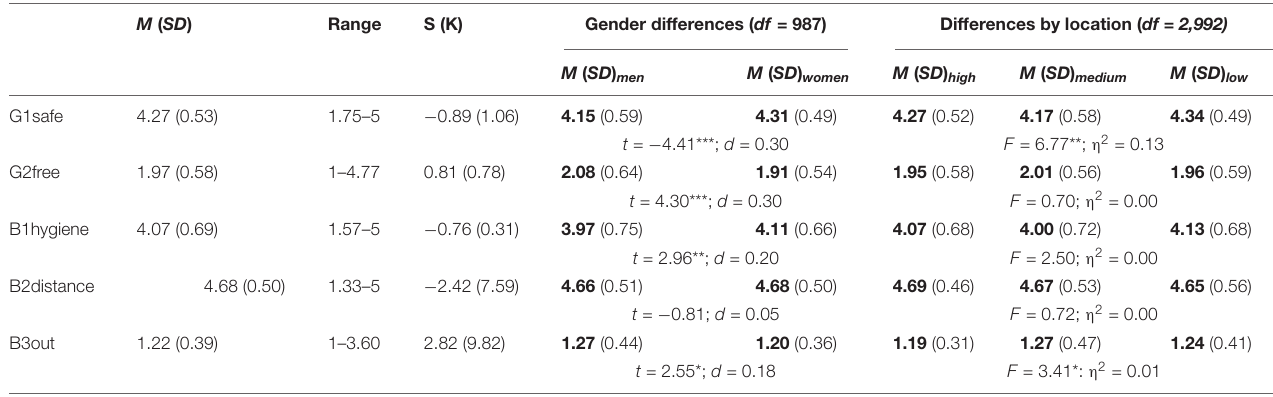
TABLE 6 | Descriptive statistics of goals and